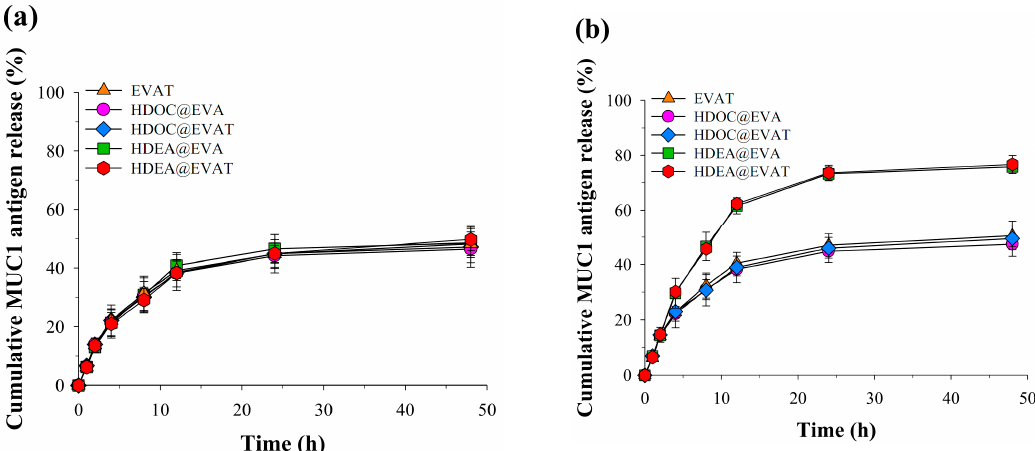
Figure 3. MUC1 antigen release kinetics from EVs at pH values of ( a ) 7.4 or ( b ) 6.5 for 48 h ( n = 3).